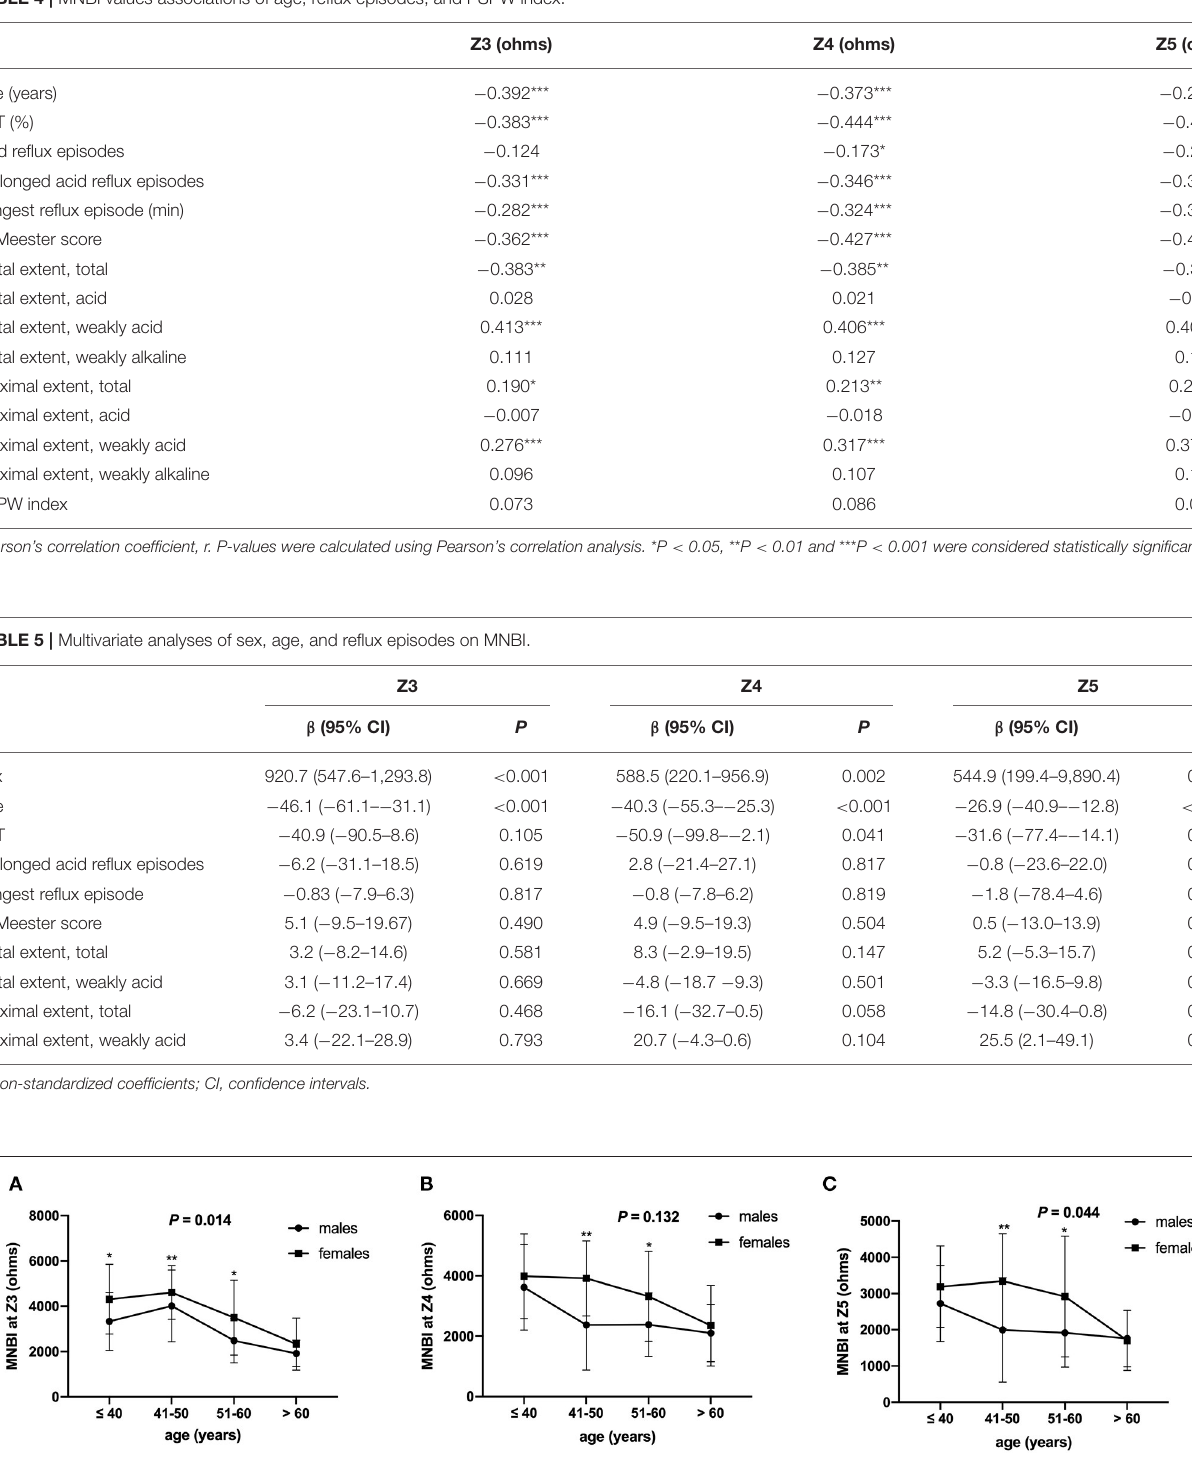
FIGURE 2 | MNBI values at different ages based on sex. MNBI values decreased with increasing age in both males and females, and an interaction effect was observed for age and sex with MNBI values at Z3 (A) and Z5 (C) , but not at Z4 (B) . MNBI, mean nocturnal baseline impedance. * P < 0.05 and ** P < 0.01 for males and females in each age